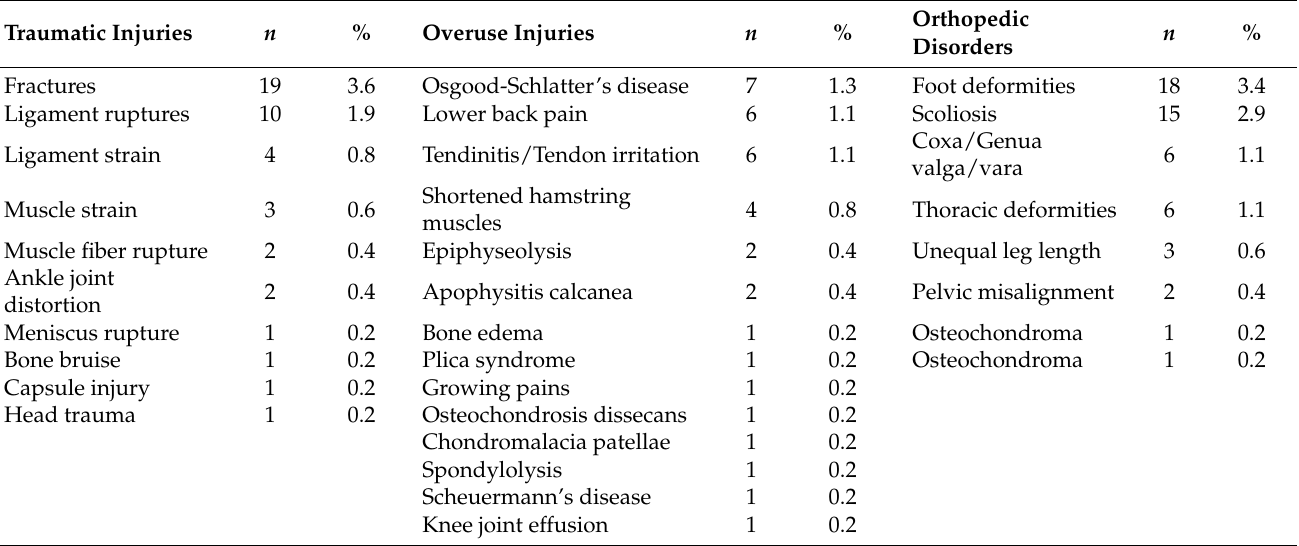
Table 6. Traumatic and overuse injuries as well as orthopedic disorders, indicated as number of cases ( n ), ordered by frequency, and given as a percentage of the total study population (%).